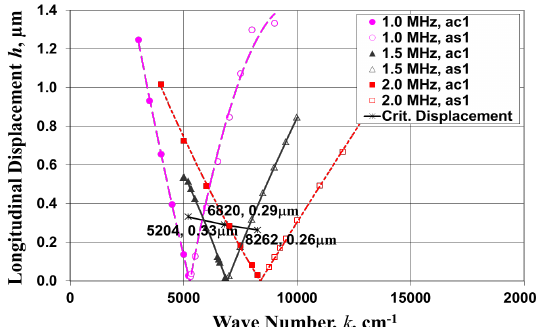
Figure 6. Stability charts and vibration amplitude thresholds (critical displacement) for Faraday wave instability in the most unstable region (bounded by the two characteristic curves designated as ac1 and as1 in the legend) at the drive frequencies of 1.0, 1.5, and 2.0